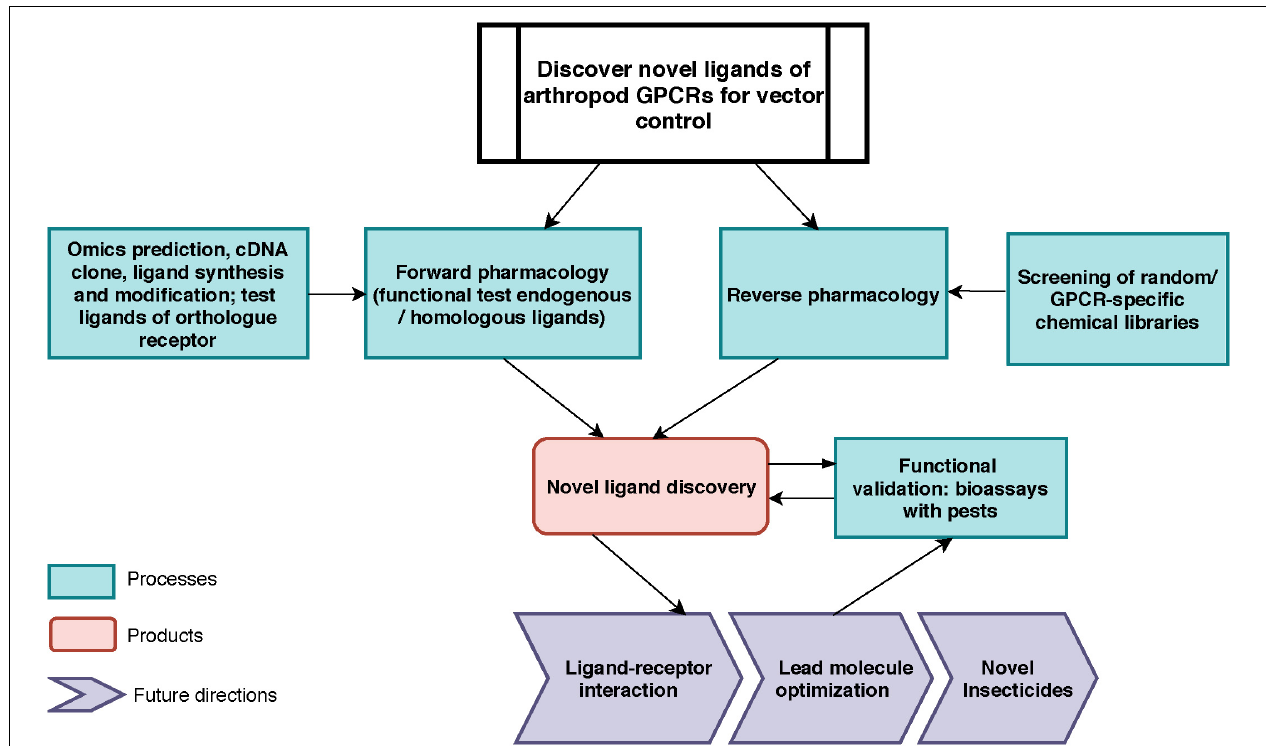
FIGURE 1 | Toward vector control: General work-flow for the discovery of novel ligands for arthropod vector GPCRs. For forward pharmacological characterization of GPCR, endogenous ligands can be identified by in silico predictions, cloning, tissue extraction and purification, and subsequently be synthesized (e.g., neuropeptides). Ligands from known orthologs or pseudo-orthologous GPCRs from other animals could be tested (this work). For reverse pharmacology, GPCR-specific or random molecule libraries can be screened on the target GPCR. In both approaches, the active endogenous ligands and screened molecules will be validated through bioassays for their physiological functions in vivo . The outputs of this pipeline are: (1) endogenous ligand(s) identification; (2) novel small molecule discovery (3) knowledge of novel biological function of neuropeptide receptor; (4) data for receptor-ligand interactions modeling and for novel chemistry